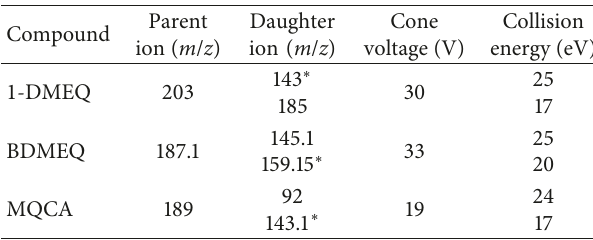
Table 2: SPE purification efficiency of MCX, MAX, and HLB cartridges for target